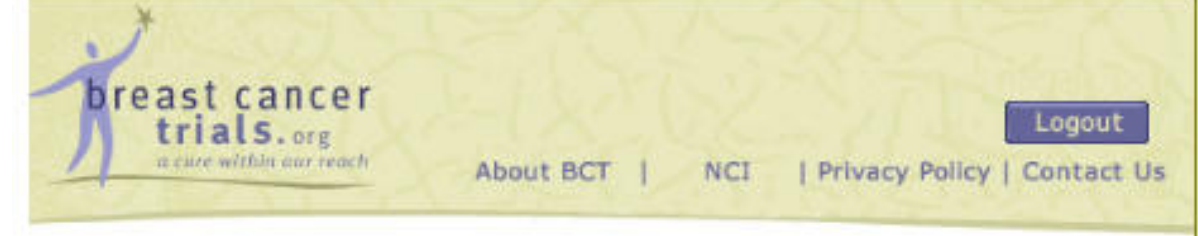
Figure 2. A section from the My Health portion of the BreastCancerTrials.org health history